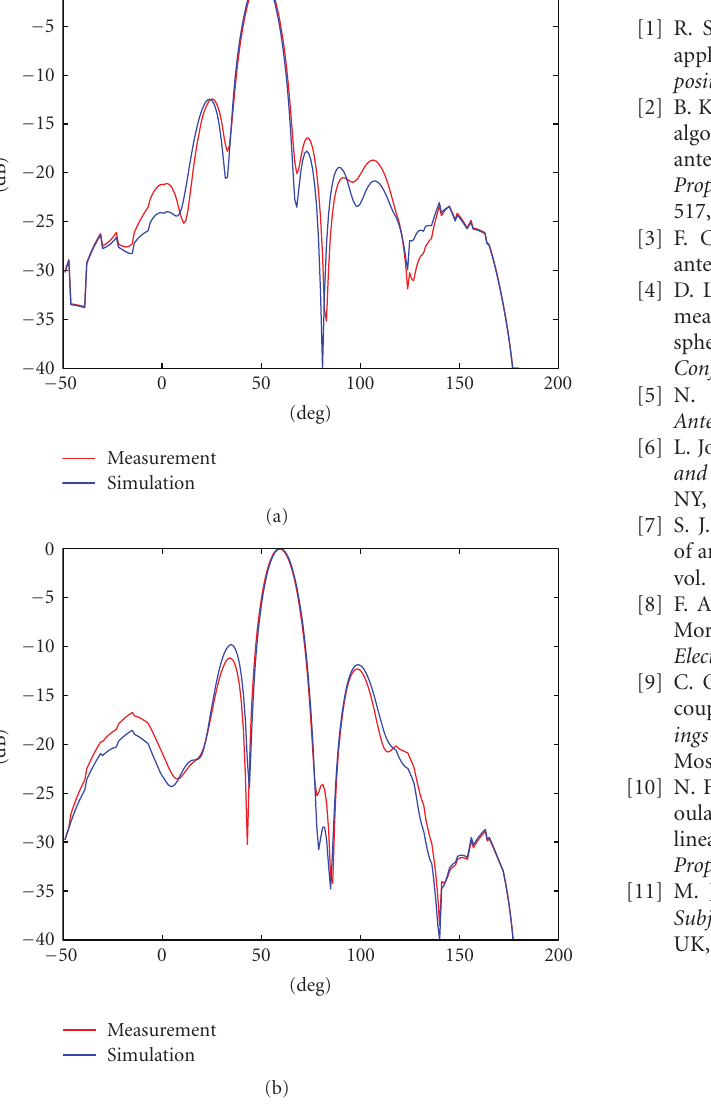
Figure 8: (a) Steering one lobe (50 ◦ ) and nulling (80 ◦ ). (b) Steering one lobe (60 ◦ ) and nulling (85 ◦